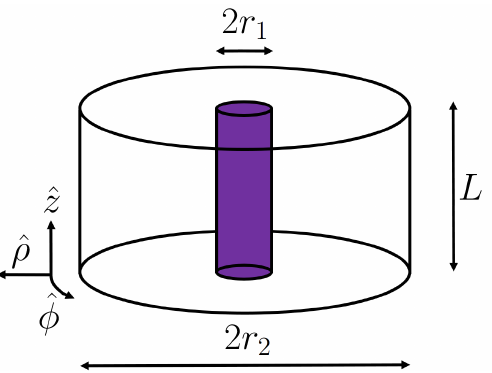
Figure 13. The coaxial geometry where the outer cylinder is the volume occupied by the resonance cavity and the inner cylinder is an homogenous plasma